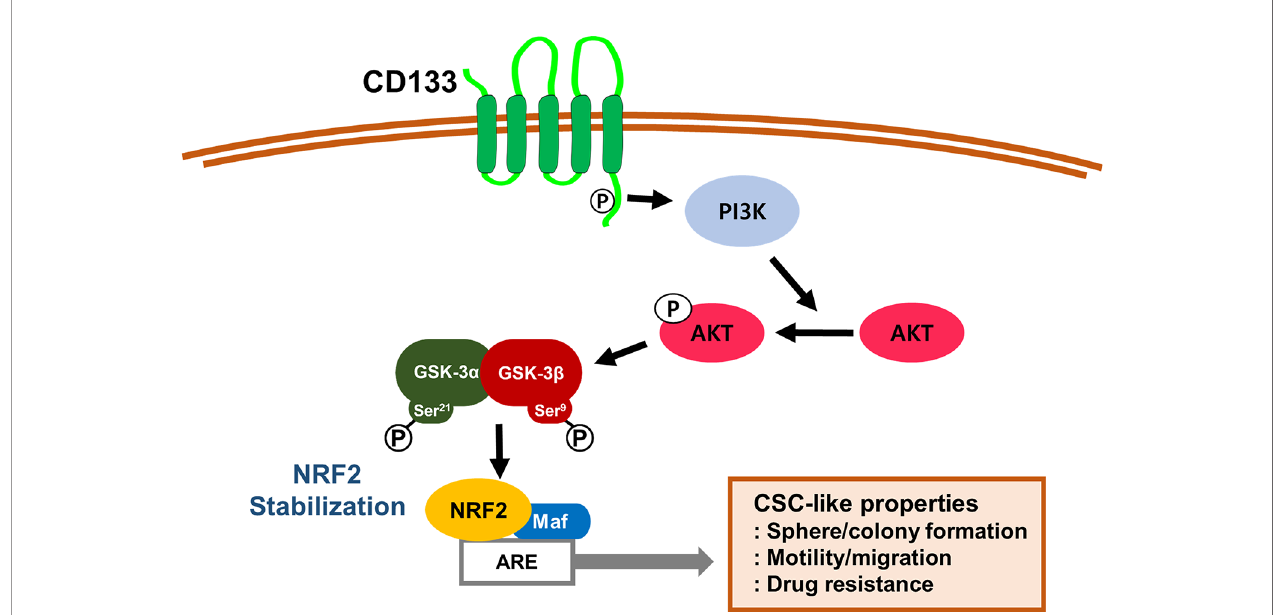
FIGURE 7 | A schematic diagram of the activation of NRF2 signaling and the development of CSC-like properties in CD133-enriched cancer cells. In colonospheres and the CD133-positive cell fraction, high CD133 levels induce PI3K/AKT activation and subsequently inactivate GSK-3 b to stabilize NRF2 protein, which results in the acquisition of CSC-like properties, including anchorage-independent growth, sphere formation, facilitated migration, and resistance to anticancer